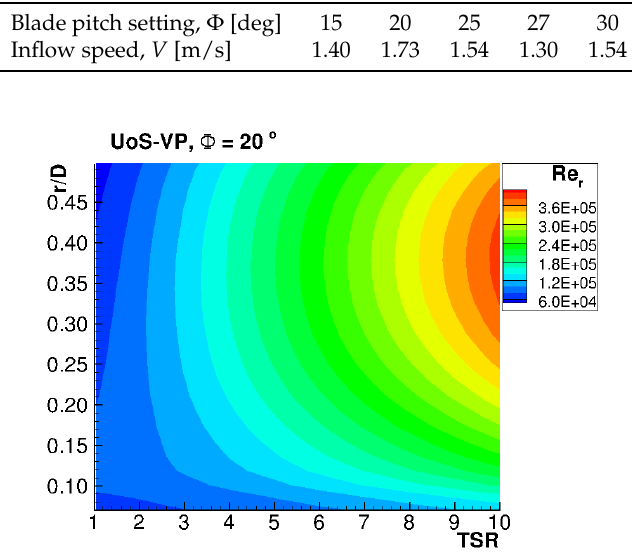
Figure 17. UoS-VP turbine. Wake geometry of BIEM model at different operating conditions. From left to right , TSR = 3, 6, 9. Design pitch setting, Φ = 20 ◦ . Table 3. UoS-VP turbine. Inflow speed conditions.